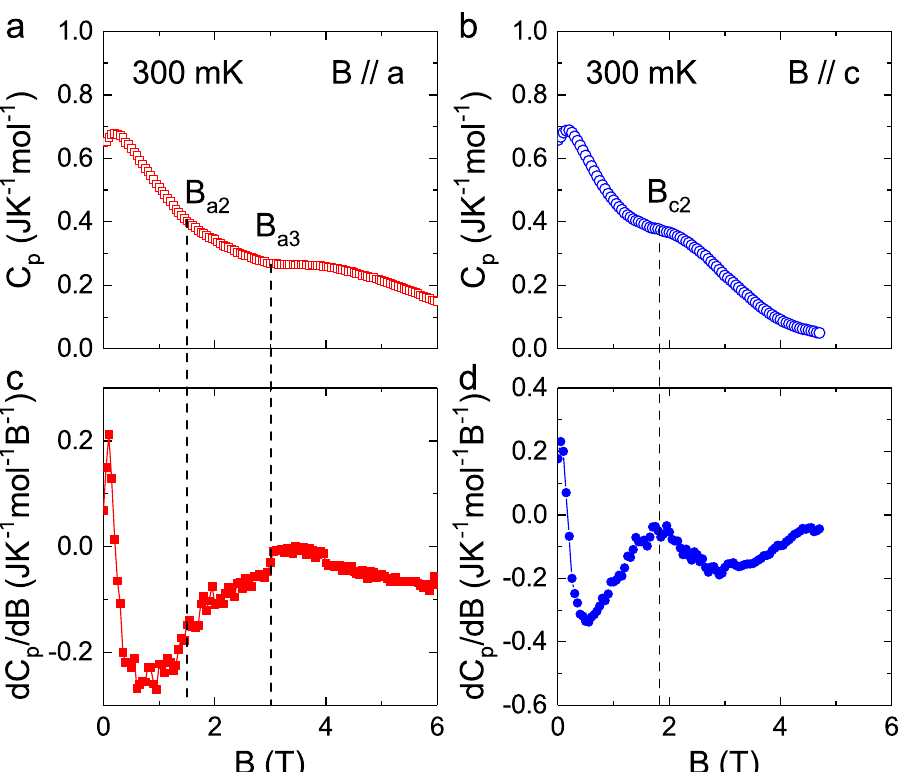
Fig. 3 Low-temperature speci fi c heat of YbMgGaO4. a , b The magnetic- fi eld dependence of speci fi c heat, C p , measured at 300mK and with B // a or B // c . c , d The derivative (d C p /d B ) for B // a or B // c . The dashed lines are the guide for eyes and indicate the anomalies associated with some transition fi elds B a2 , B B a3 , and c2